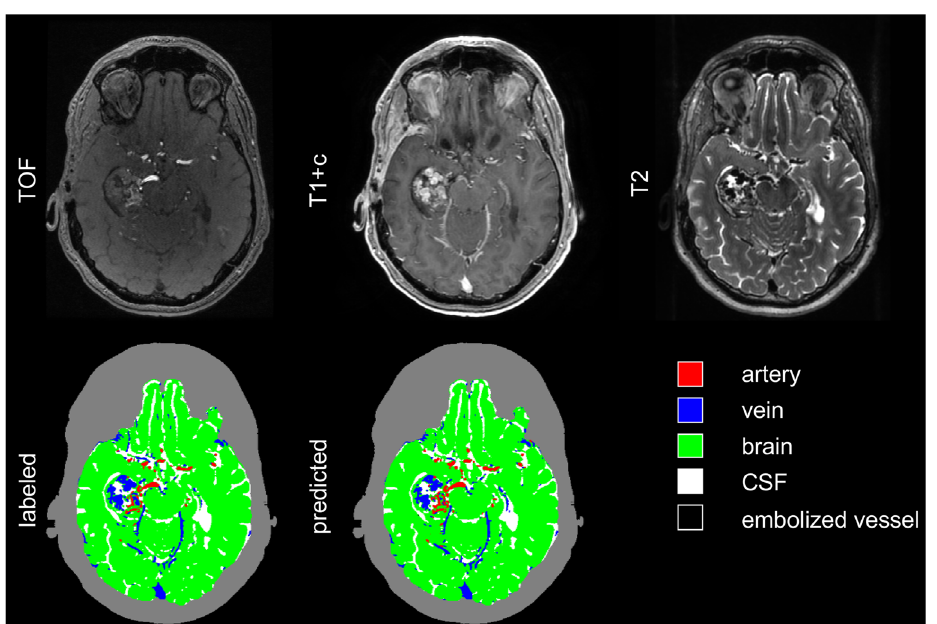
Figure 2. Representative images of an AVM nidus in the right temporal lobe as demonstrated by multi-modal MRI/MRA and vascular anatomical maps. Dice similarity coefficients for this slice: arteries 0.85; veins 0.84; brain 0.98; CSF 0.94; embolized vessels 0 (not present). The grey contour outlining the extracranial space is not generated by the segmentation algorithm and is included for visual reference only. AVM: